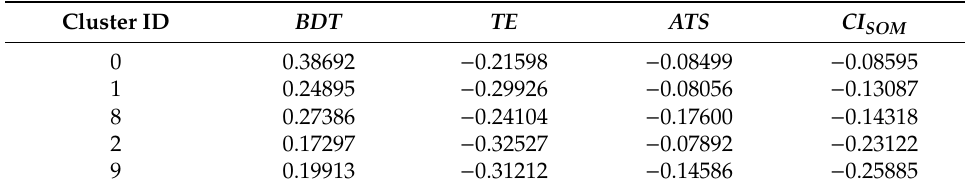
Table 7. Examples of the congested RSBs. Route